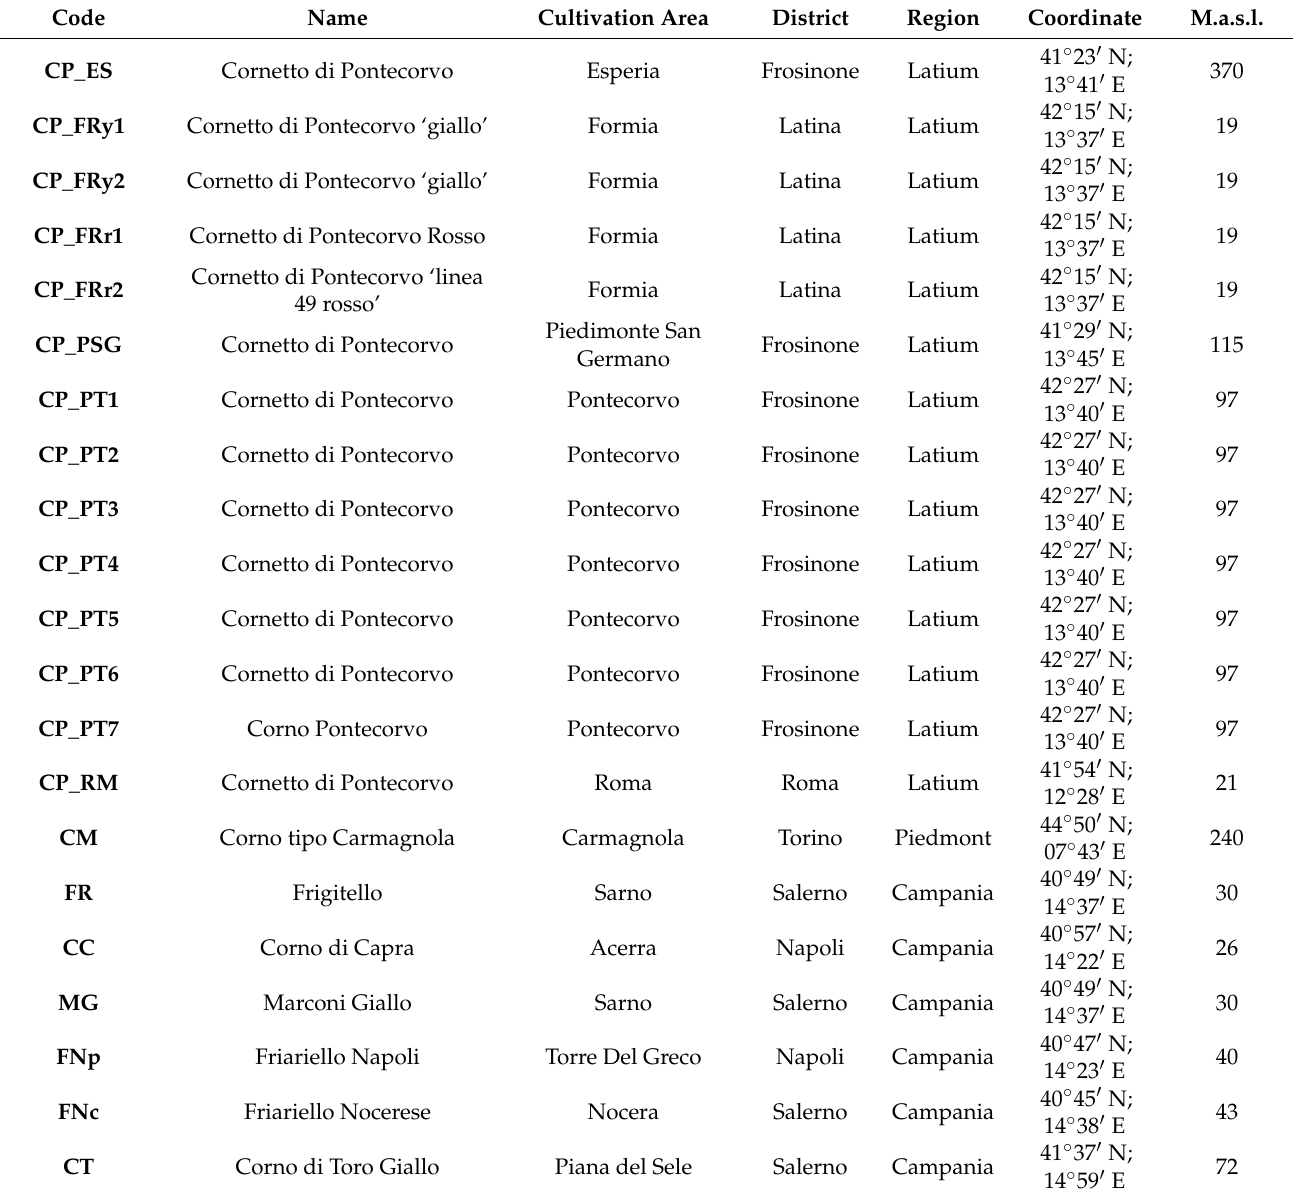
Table 1. List of accessions studied and details of their area of